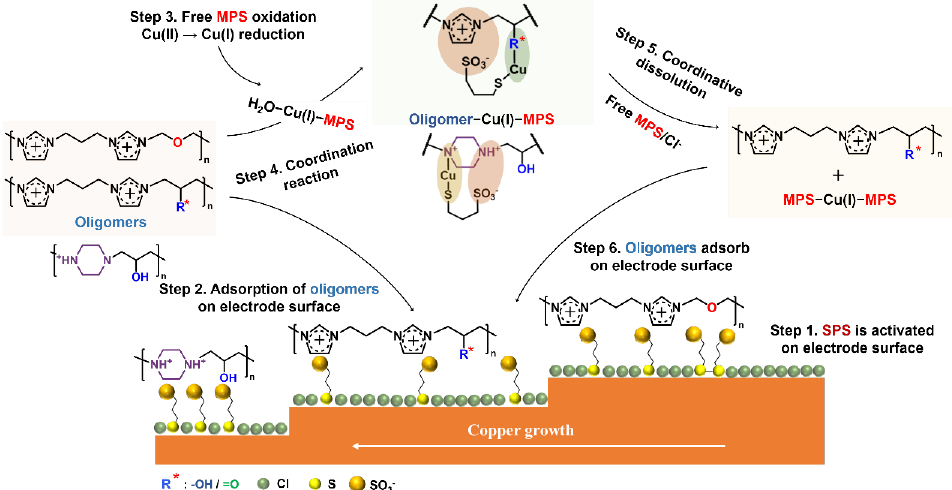
Figure 10. Schematic diagram of N-heterocyclic oligomers action mechanism in the bath.